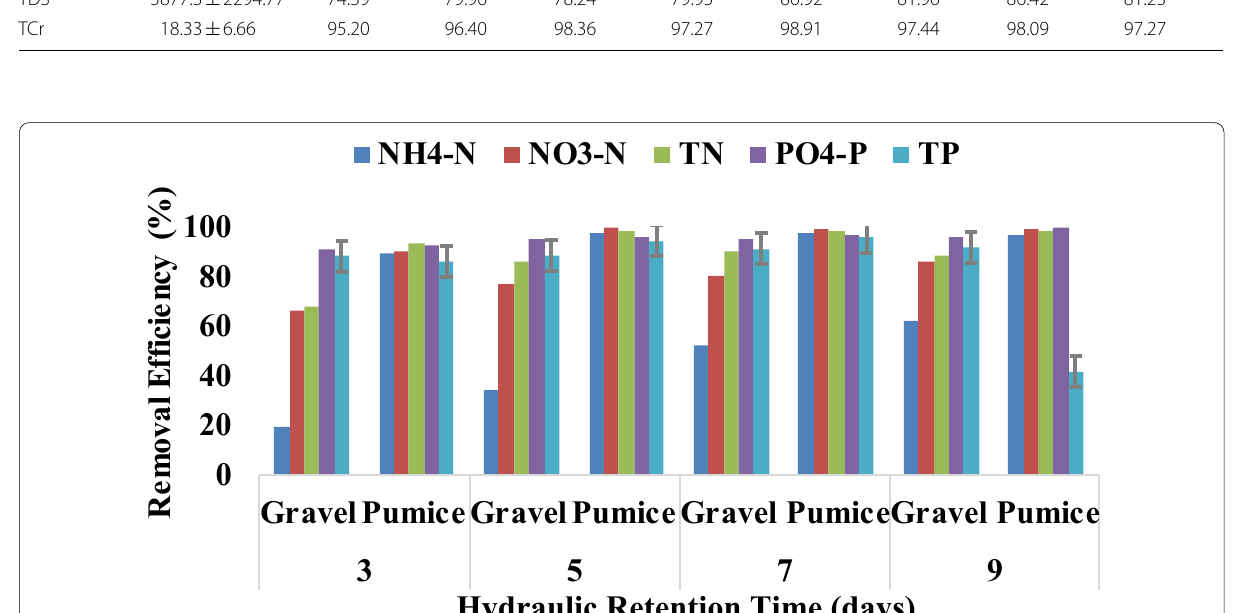
Fig. 7 Nutrient removal efficiency of HSSFCW with Gravel and pumice